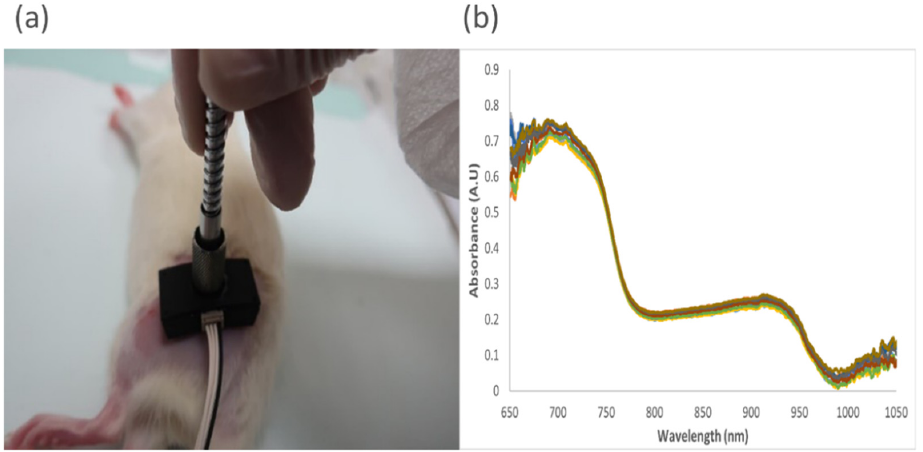
Figure 3. ( a ) The test bed for NIRS acquisition; ( b ) the raw absorption spectra for multiple meas- urements on a single point.